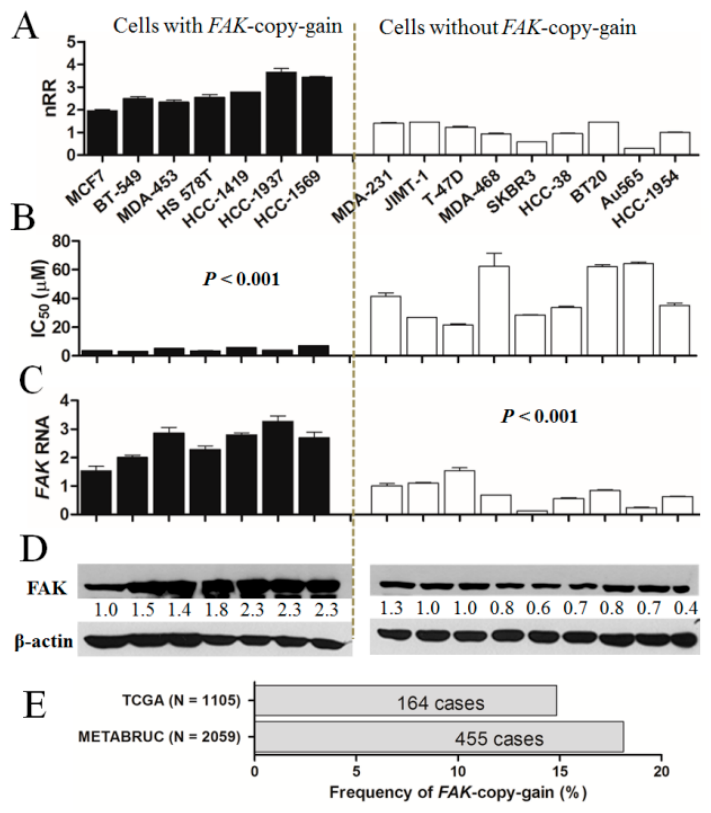
Figure 2. Significant correlation between FAK-copy-gain and sensitivity to F14 in breast cancer cells.